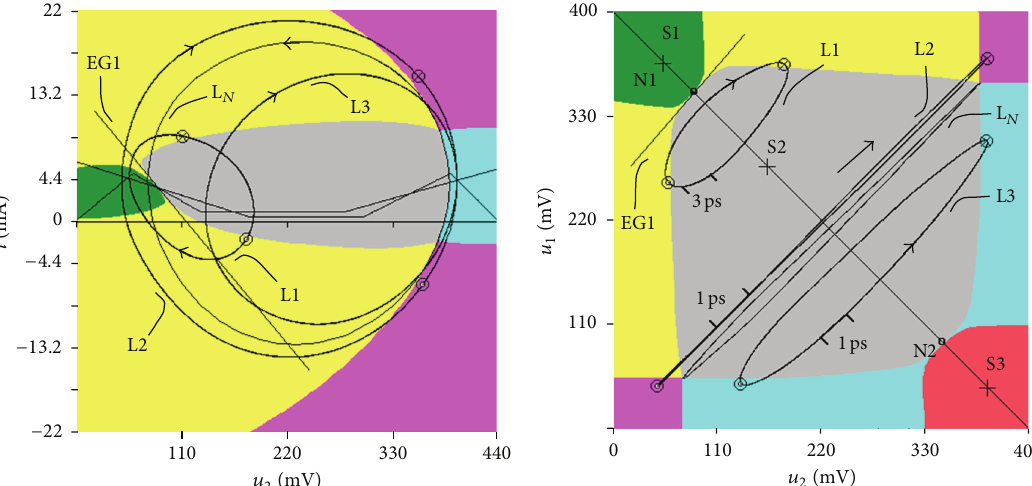
Figure 3: Monge’s projection of the cross-section (in singularity N1) of the boundary surfaces, stable limit cycles, and unstable limit cycle for considered 𝑅 = 0 , 𝐿 = 1 ⋅ 10 −10 H, and 𝐶 1 = 𝐶 2 = 5 ⋅ 10 −13 F [27].